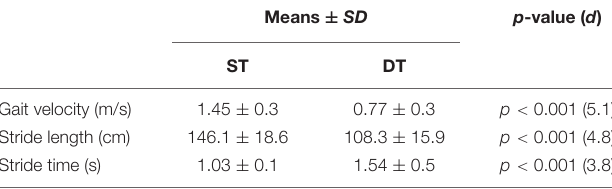
TABLE 2 | Outcome measures [ANOVA with within-factor Condition (ST vs.